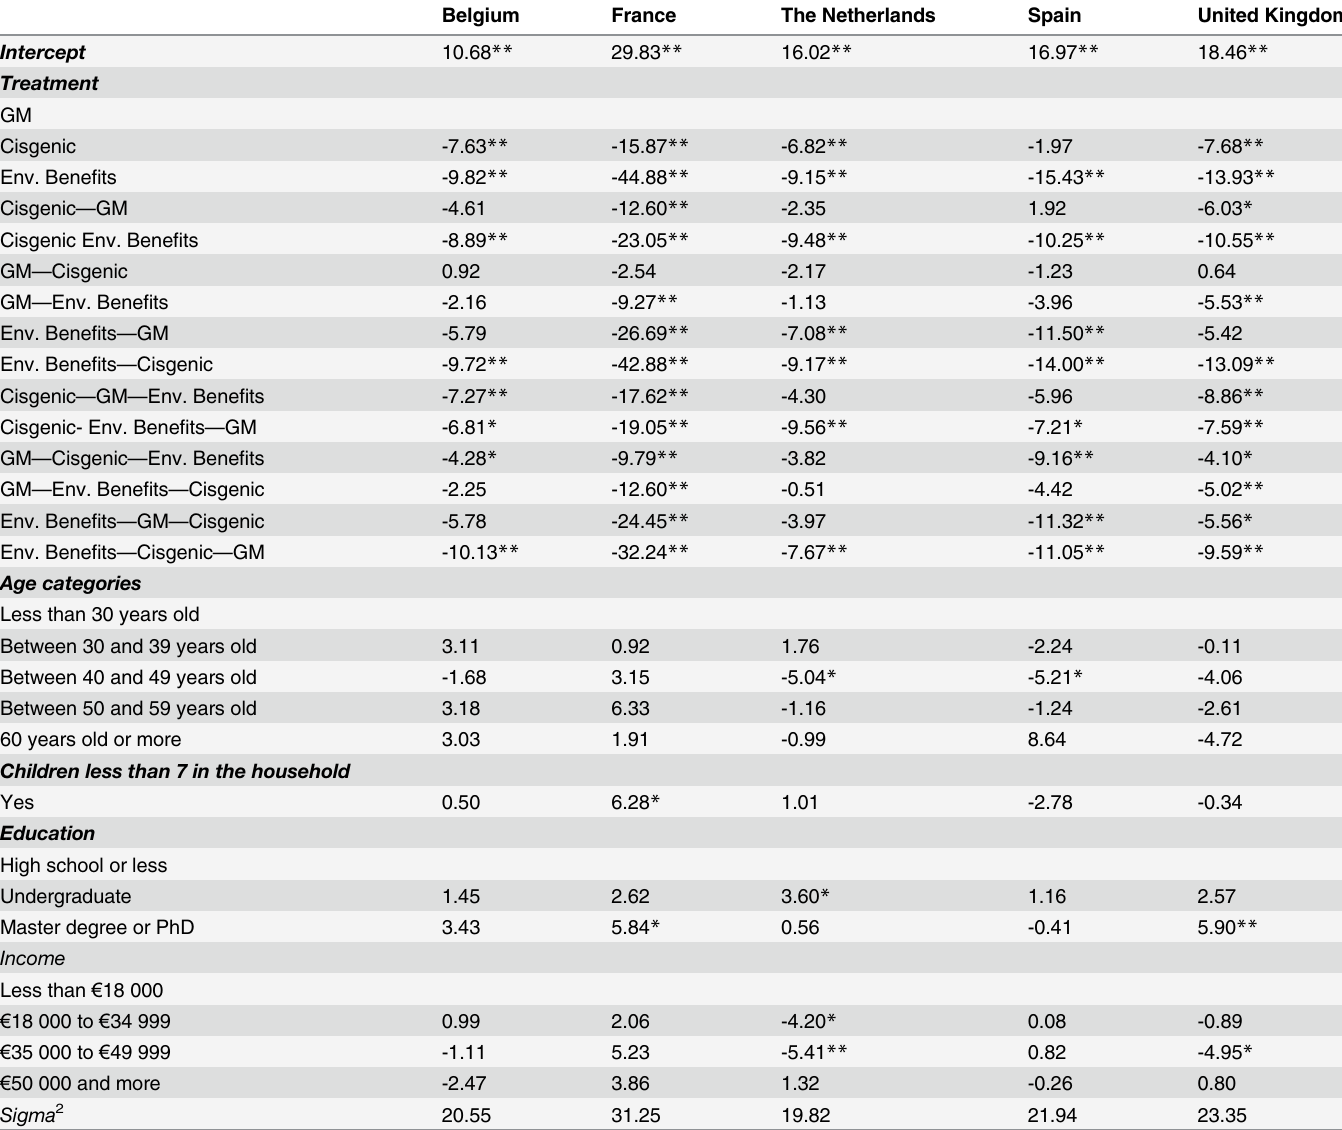
Table 4. Interval regression results of WTP to consume conventional rice instead of the alternative, by country 1